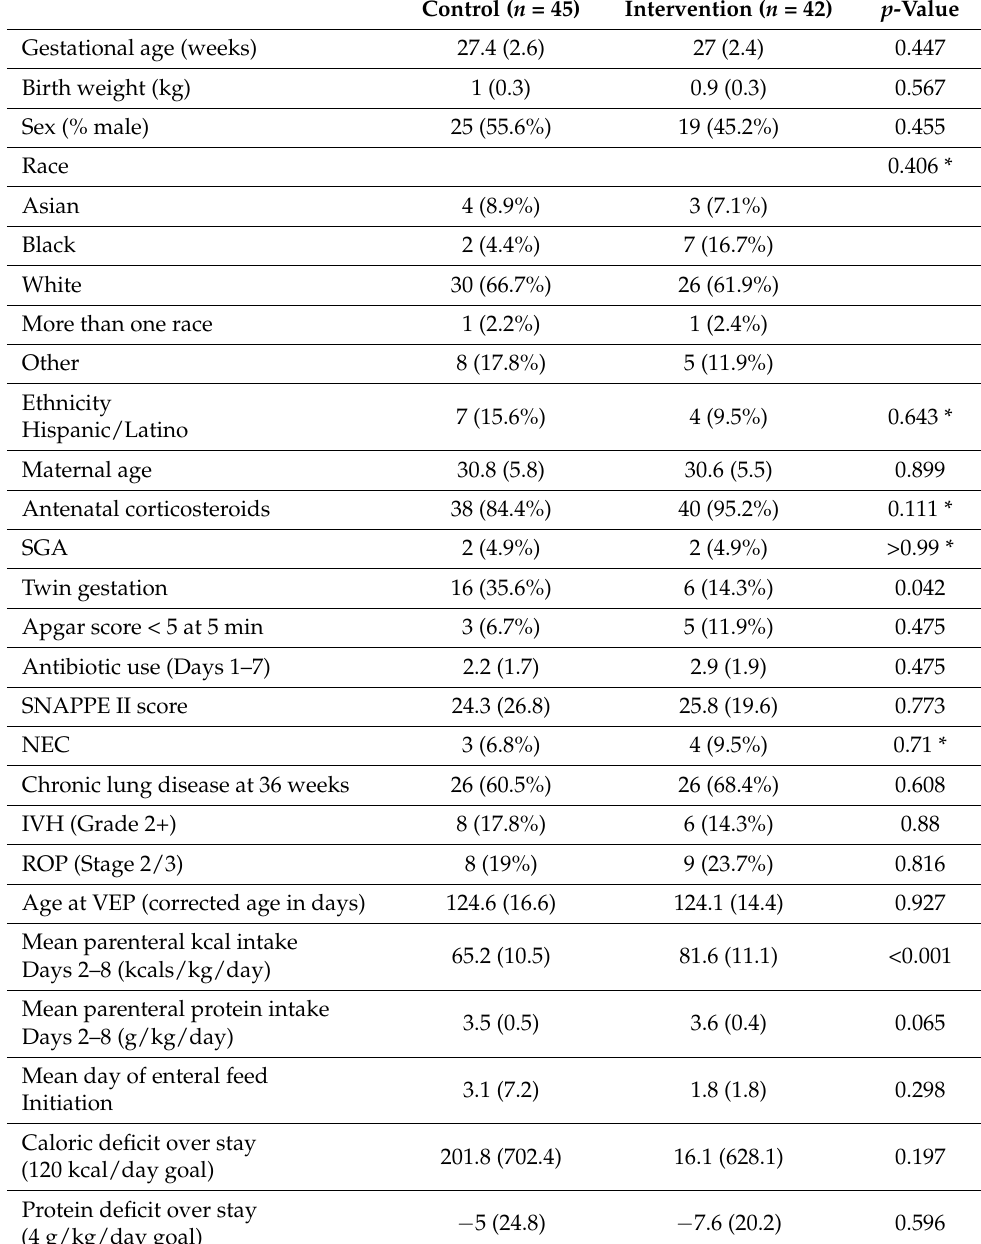
Table 1. Infant demographics and baseline inpatient variables. Results displayed as mean (SD) or n